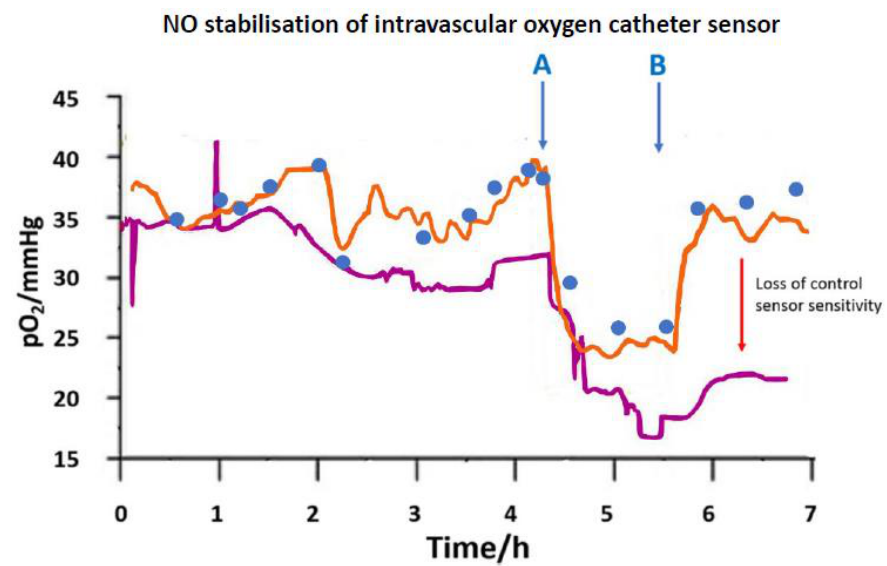
Figure 2. Double lumen intravascularly placed O 2 catheter with haemo-protective NO delivery used in rabbit jugular vein. ( - ) NO flow protected O 2 sensor, ( - ) control O 2 sensor. Blue filled circles are intermittently sampled venous blood pO 2 values assayed by in vitro analyser. ( A ) 100% inspired O 2 was switched to 21%. ( B ) Return to 100% inspired O 2 Adapted from [38].